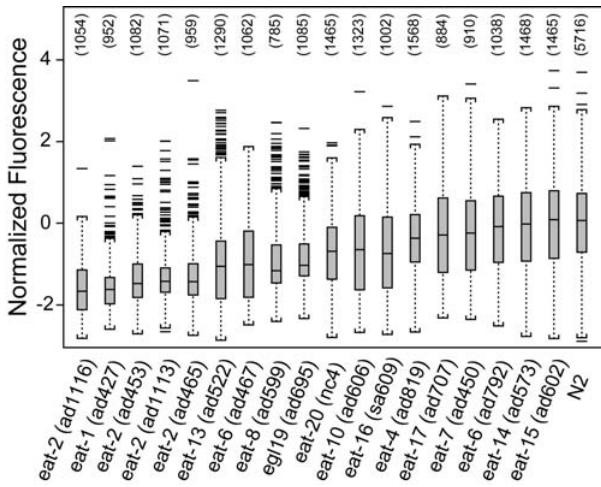
Figure 2. Comparison of wild-type and eat mutant C. elegans feeding. Boxplots of normalized fluorescence for 19 strains of adult nematodes aggregated over all experiments. Normalization of fluores- cence measurements consisted of size-adjustment, square-root trans- formation, and centering and scaling to the respective day’s wild-type measurements. The upper and lower limits of each box give the 25th and 75th percentiles of the data respectively, and the line inside the box gives the median. Whiskers of the boxplot extend to 1.5 times the interquartile range, with extreme measurements indicated by horizontal lines. Sample sizes are given in parentheses above each boxplot.